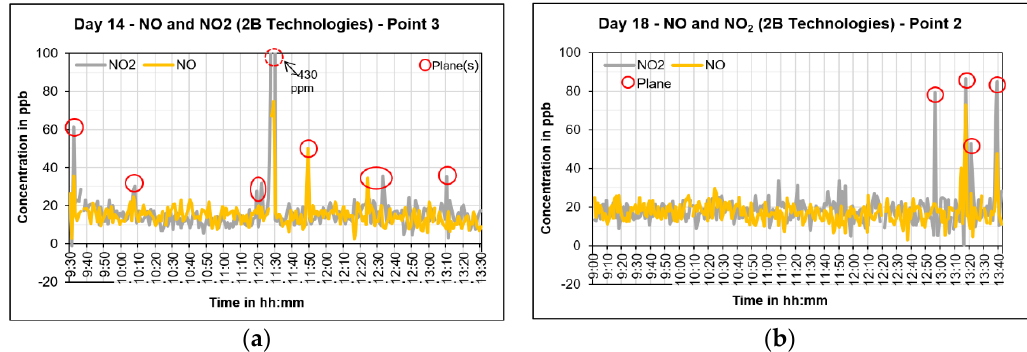
Figure 22. NO 2 concentration at point 3 on ( a ) day 9 and ( b ) day 10.